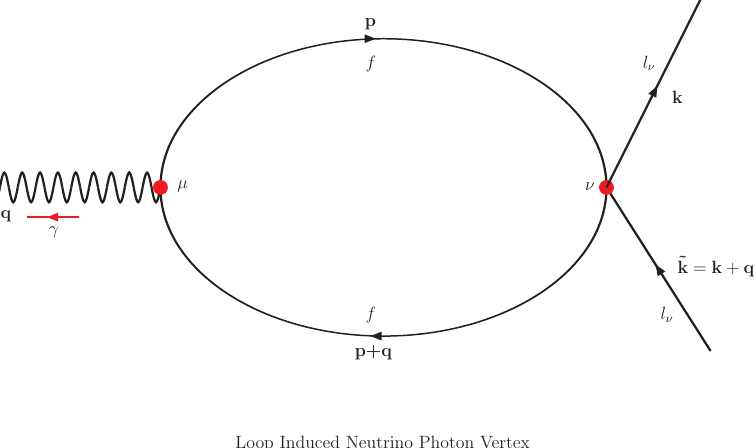
Figure 1. One-loop diagram for the effective electromagnetic vertex of the neutrino in the limit of infinitely heavy W and Z